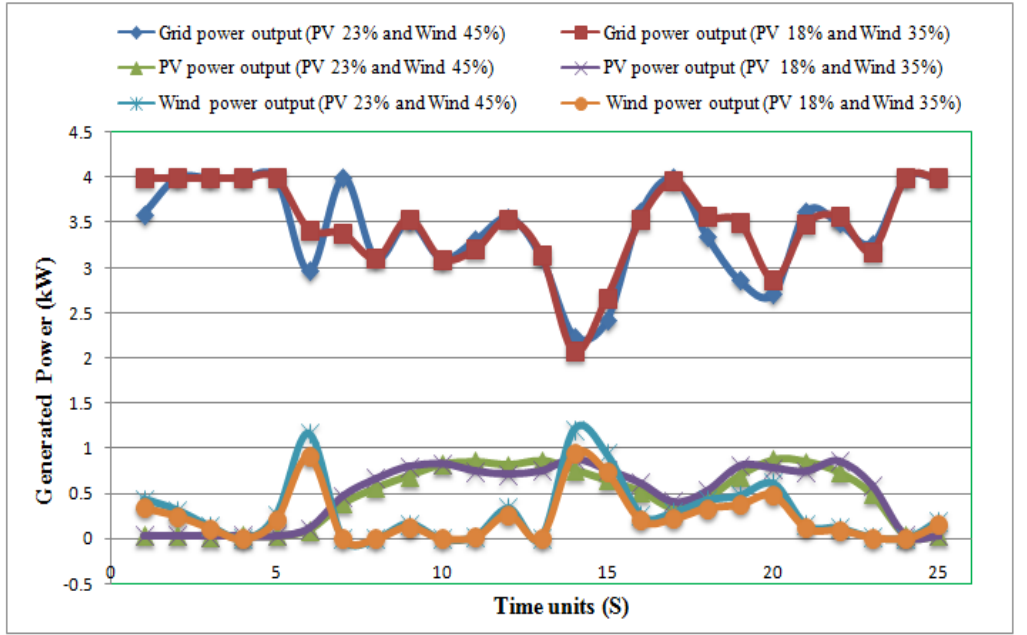
Figure 24. Hybrid sources energy conservation by improving energy efficiency.